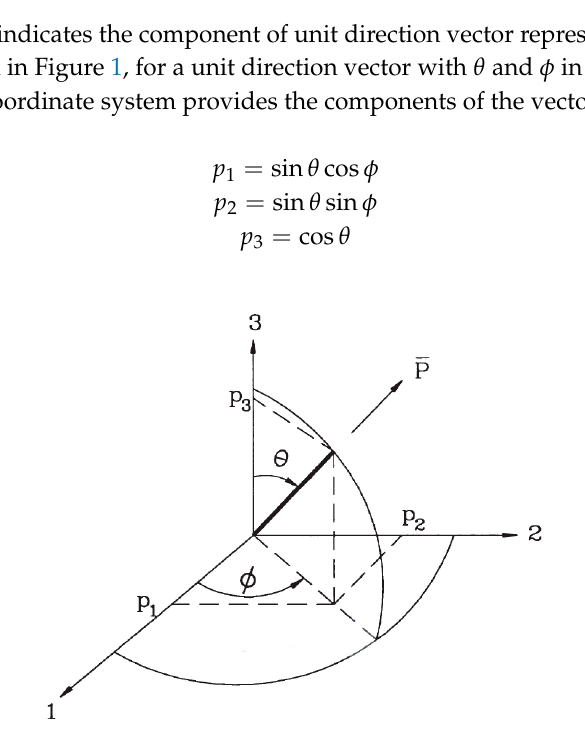
Figure 1. Coordinate system to express the fiber orientation.